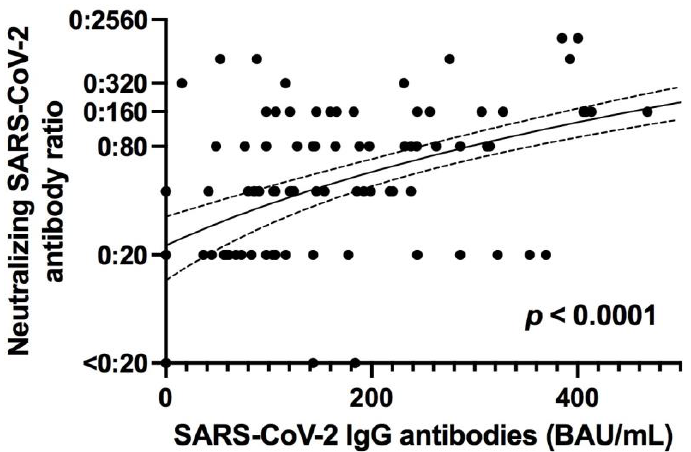
Figure 7. Correlation of neutralizing SARS-CoV-2 antibody ratio and SARS-CoV-2 IgG antibodies against S protein, as measured with a chemiluminescence enzyme immunoassay (CLIA). BAU, binding antibody unit; IgG, immunoglobulin G. p < 0.0001, R = 0.6, regression line (black line) with 95% confidence interval (dashed lines).